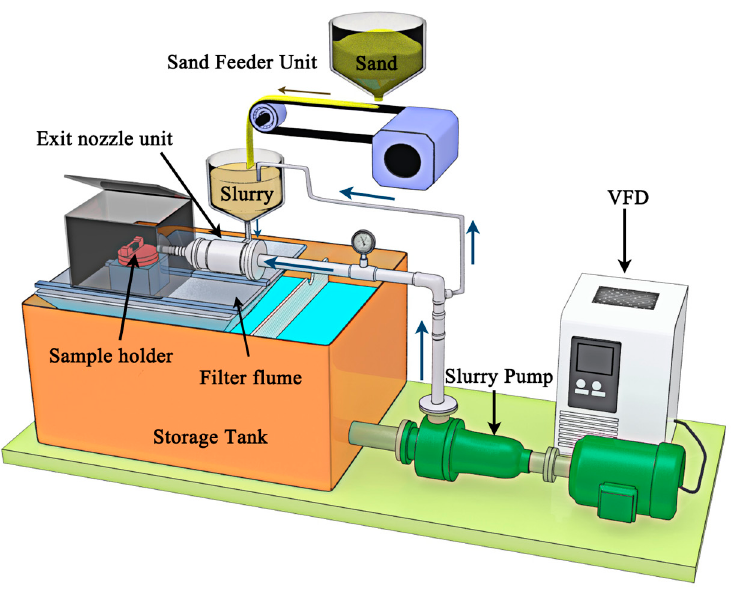
Figure 1. Schematic view of the slurry erosion test rig.